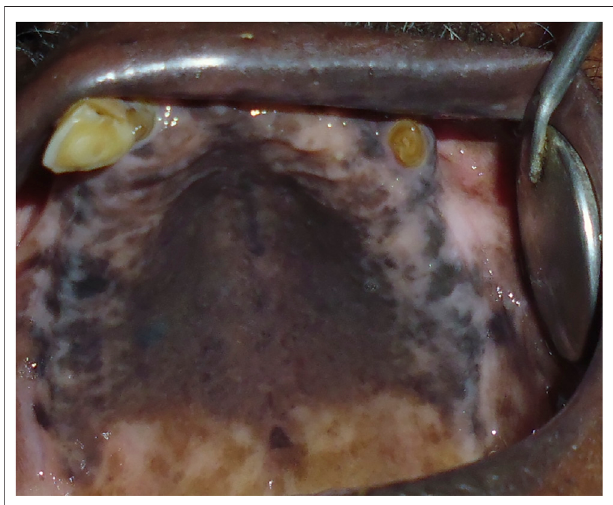
FIGURE 13 | Clinical presentation of palatal lesions in reverse